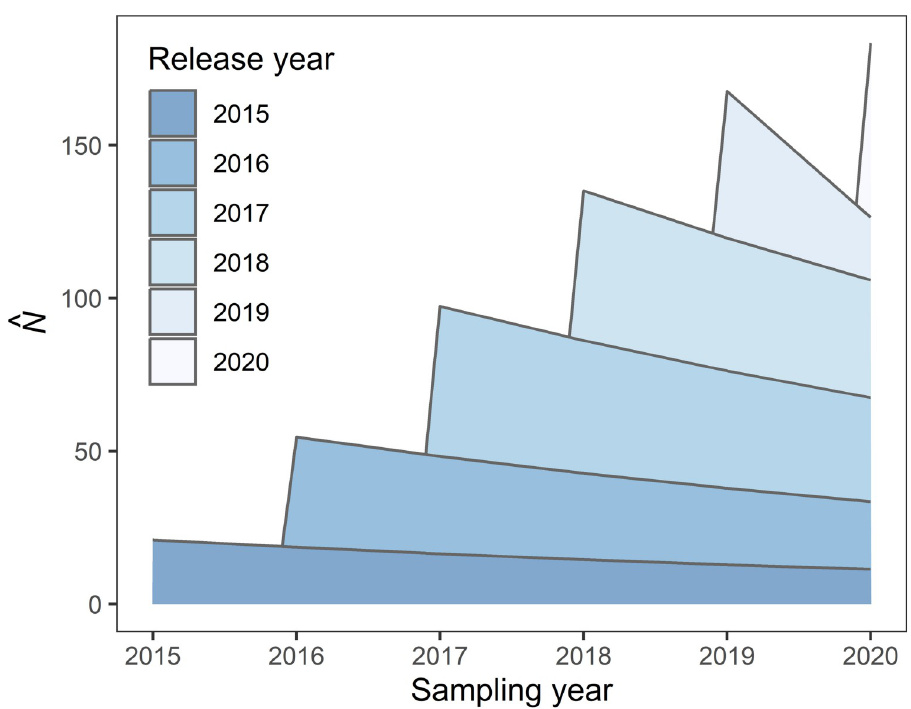
Fig 5. Headstarted Blanding’s Turtle abundance in the Rouge National Urban Park based on release year. The population size ( ^ N ^ ) increased each year but the number of turtles in each cohort decreased each year as a result of mortality. The total abundance in 2020 was 218 headstarted turtles.